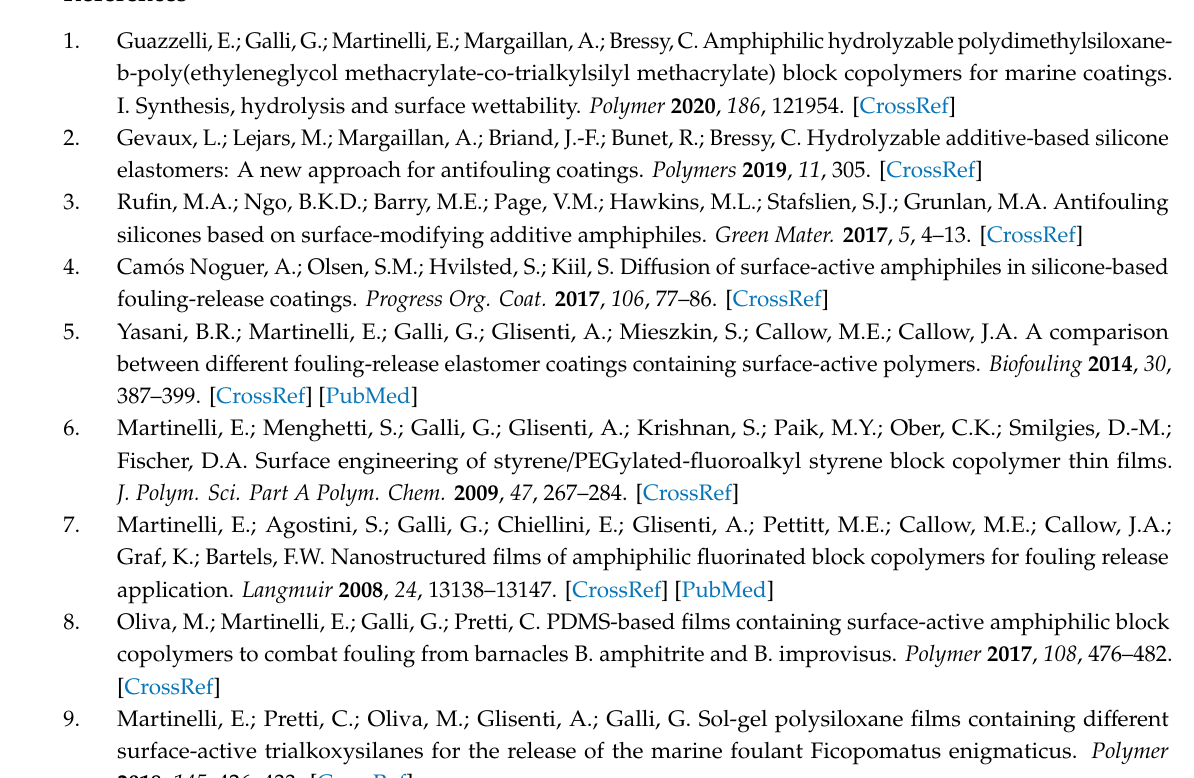
FigureS1: 19 FNMRspectrumofS27SzA3. FigureS2: SECtracesofblockcopolymerS27SzAnandthecorresponding macroinitiator S27. Figure S3: Reaction scheme of glass functionalization by GPS and SEBS-MA anchorage. Figure S4: Deconvolution of the C(1s) signal for the film E13-S27SzA11_100 at ϕ = 70 ◦ before immersion in